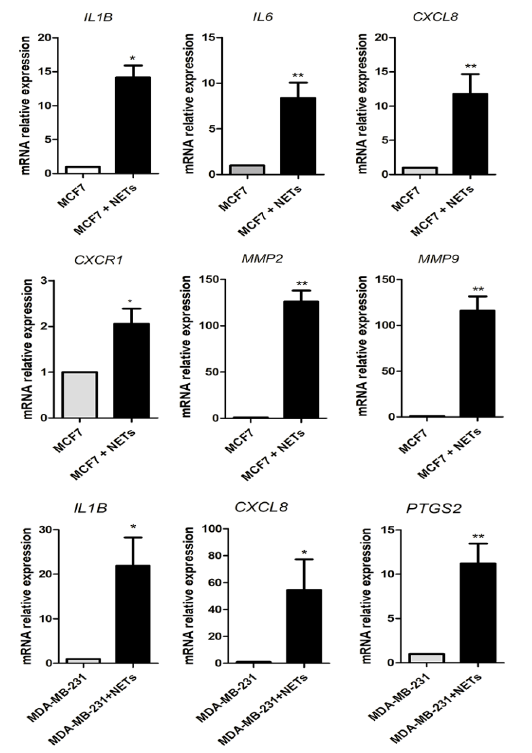
Figure 4. Pro-tumoral and pro-inflammatory mediators are regulated by NETs. MCF7 cells (5 × 10 5 ) were starved and further cultured for 16 h in the absence (grey bar) or the presence (black bar) of